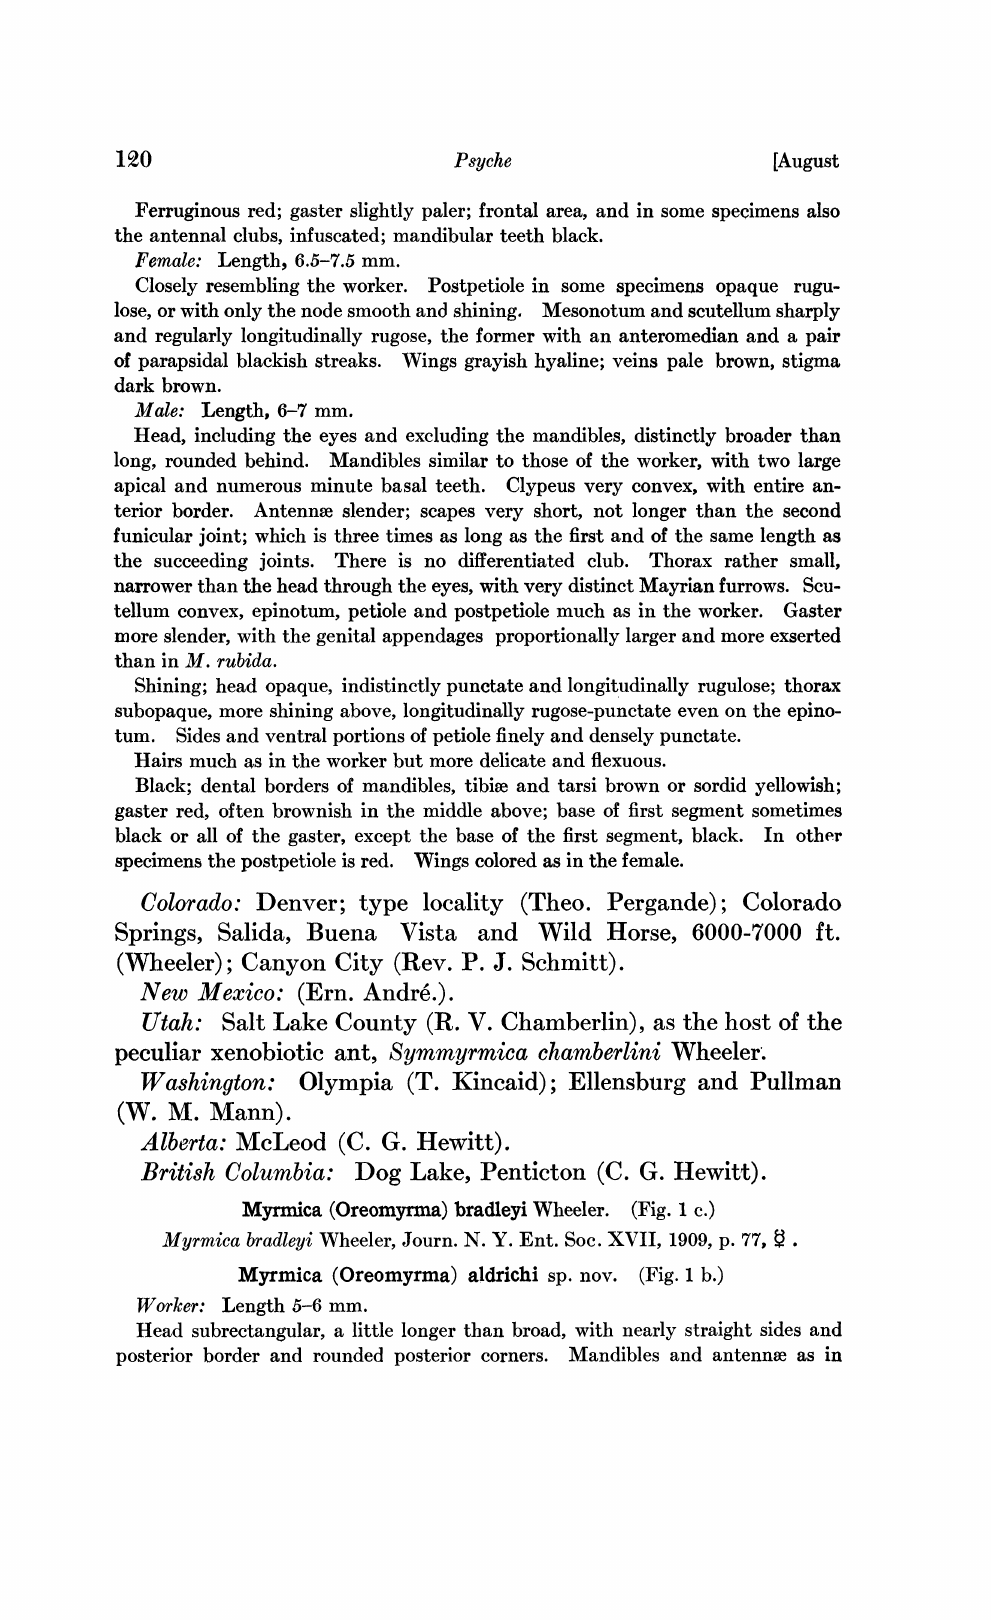
Ferruginous red; gaster slightly paler; frontal area, and in some specimens also the antennal clubs, infuscated; mandibular teeth black. Female: Length, 6.5-7.5 ram. Closely resembling the worker, t)ostpetiole in some specimens opaque rugu- lose, or with only the node smooth and shining. Mesonotum and scutellum sharply and regularly longitudinally rugose, the former with an anteromedian and a pair of parapsidal blackish streaks. Wings grayish hyaline; veins pale brown, stigma dark brown. Male: Length, 6-7 ram. Head, including the eyes and excluding the mandibles, distinctly broader than long, rounded behind. Mandibles similar to those of the worker, with two large apical and numerous minute basal teeth. Clypeus very convex, with entire an- terior border. Antennm slender; scapes very short, not longer than the second funicular joint; which is three times as long as the first and of the same length as the succeeding joints. There is no differentiated club. Thorax rather small, narrower than the head through the eyes, with very distinct Mayrian furrows. Scu- tellum convex, epinotum, petiole and postpetiole much as in the worker. Gaster more slender, with the genital appendages proportionally larger and more exserted than in M. rubida. Shining; head opaque, indistinctly punctate and longitudinally rugulose; thorax subopaque, more shining above, longitudinally rugose-punctate even on the epino- rum. Sides and ventral portions of petiole finely and densely punctate. Hairs much as in the worker but more delicate and flexuous. Black; dental borders of mandibles, tibim and tarsi brown or sordid yellowish; gaster red, often brownish in the middle above; base of first segment sometimes black or all of the gaster, except the base of the first segment, black. In other specimens the postpetiole is red. Wings colored as in the